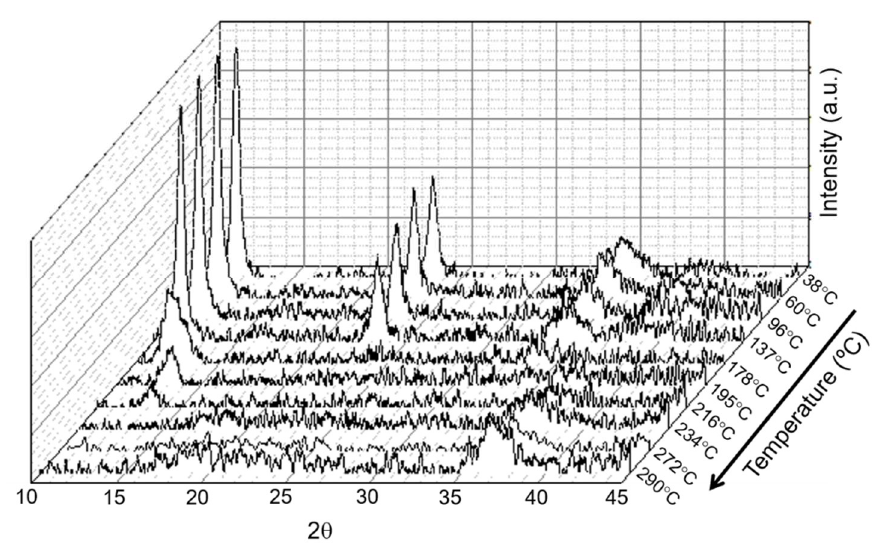
Figure 2. Temperature-programmed XRD diffractograms of CoAl starting from hydrotalcite and ending up to a mixed metal oxide structure.